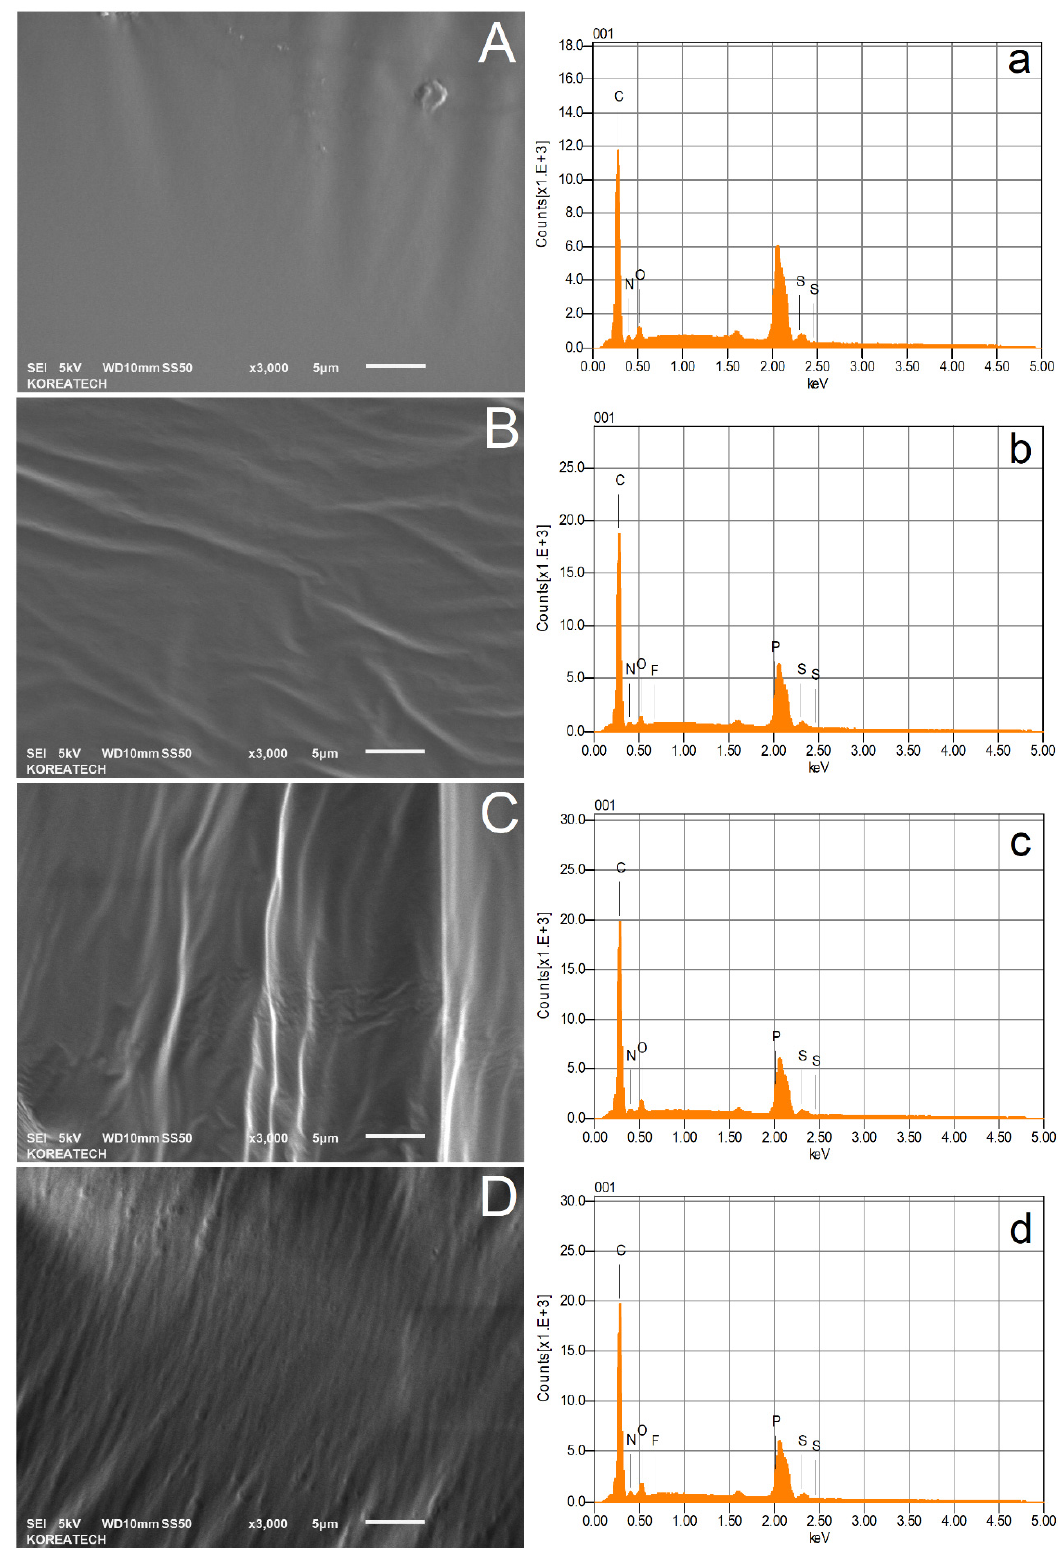
Figure 5. Scanning electron microscope (SEM) micrographs with their corresponding EDXS spectra of unmodified and DCG-modified asphalts taken at × 3000 magnification. ( A , a ) AP-5 DCG 0 wt%; ( B , b ) AP-5 DCG 3 wt%; ( C , c ) AP-5 DCG 6 wt%; ( D , d ) AP-5 DCG 9